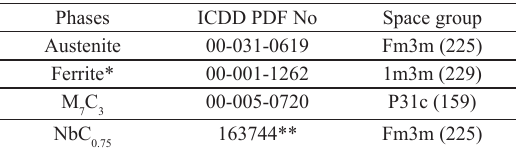
Table 2. Phase crystallographic properties.